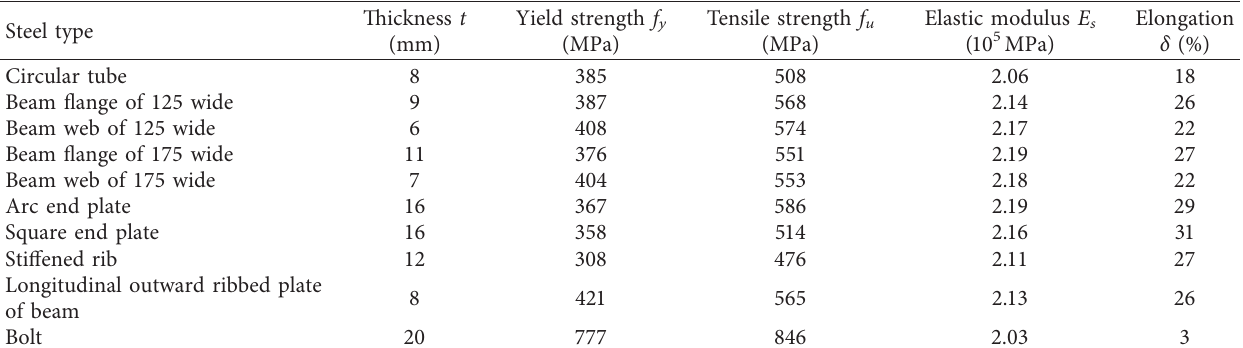
Figure 2: Details of the joints (unit: mm): (a) vertical view of joints J-1, J-2 (J-3); (b) plan view of joints J-1, J-2 (J-3); (c) vertical view of joint J-4; (d) plan view of joint J-4; (e) vertical view of joint J-5 (J-6); (f) plan view of joint J-5 (J-6); (g) bolt hole locations of joints J-1–J-3; (h) bolt hole locations of joints J-4–J-6. Table 2: Mechanical properties of steel